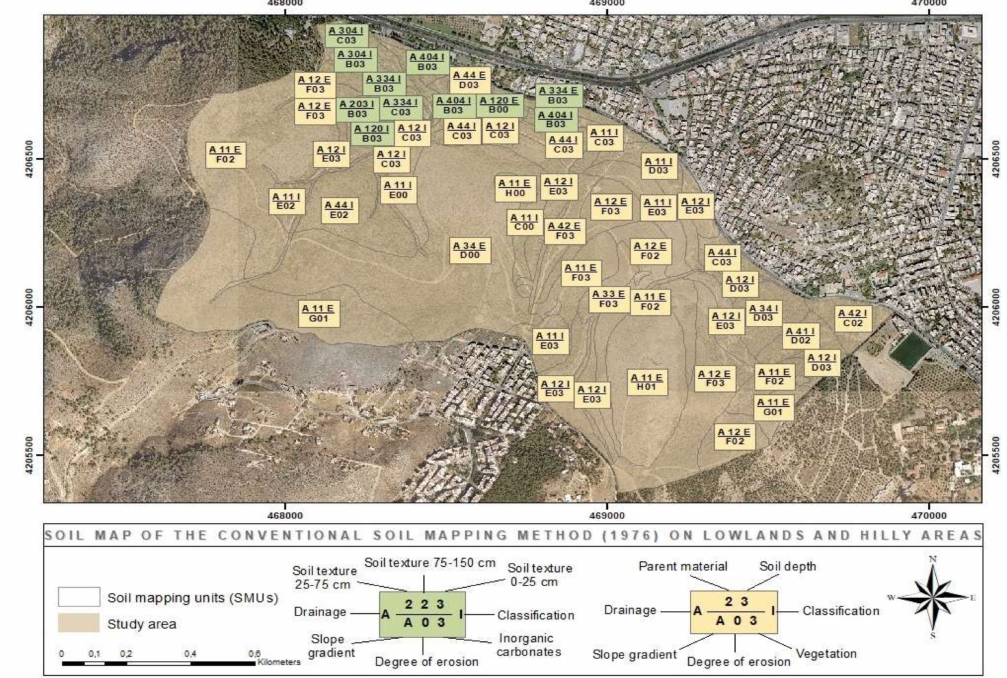
Figure 7. Soil Mapping Units (SMUs) delineations and mapping symbols according to the conventional mapping methodology (1976).